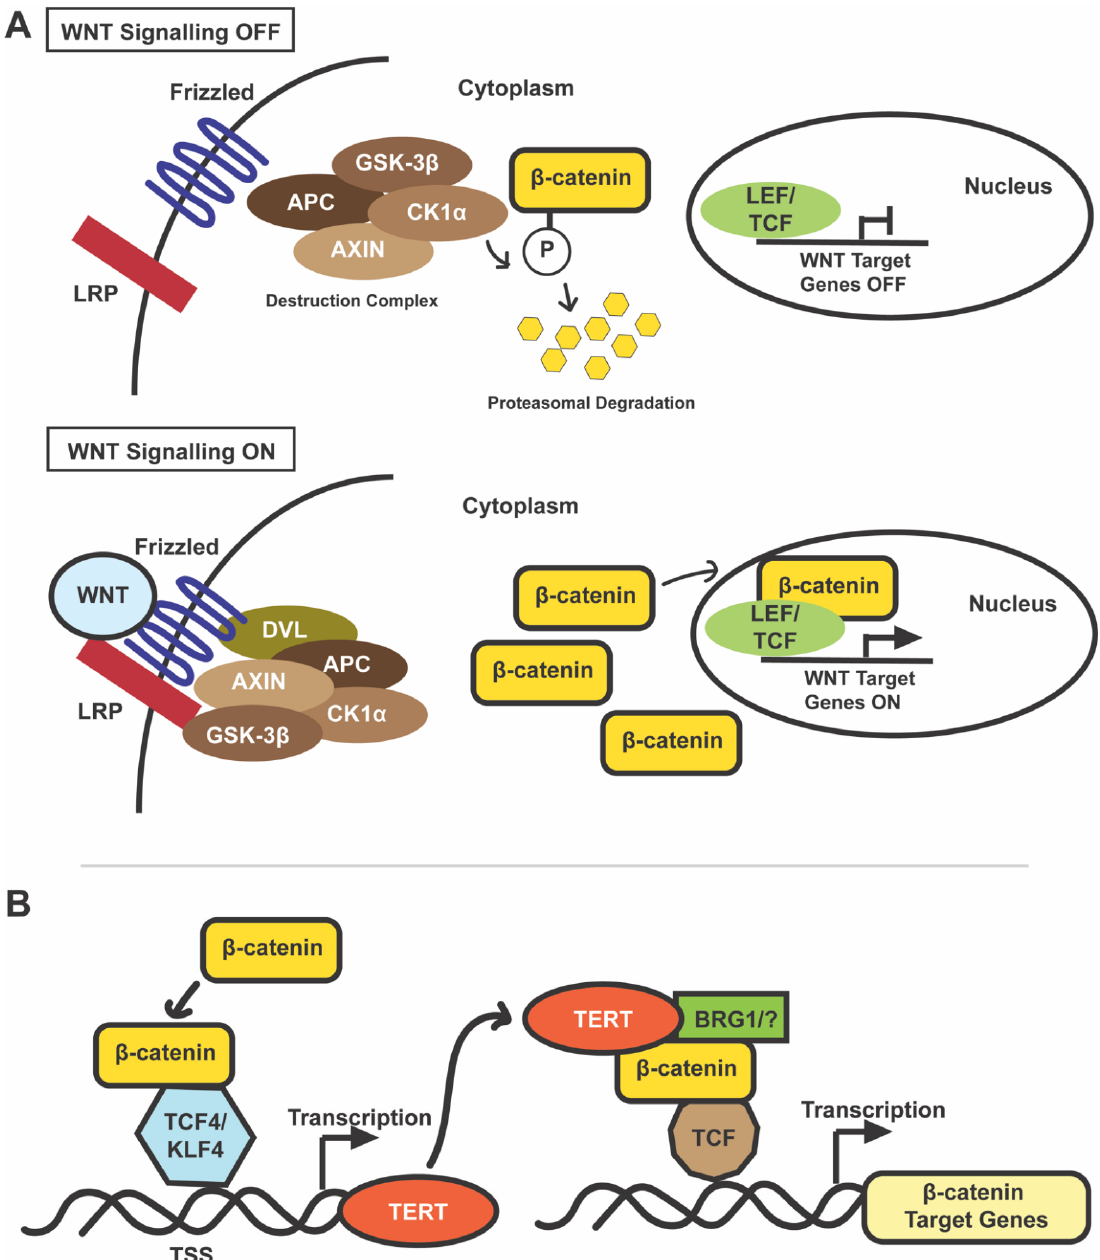
Figure 2. ( A ) Canonical WNT/ β -catenin pathway. When WNT signaling is OFF (top), cytoplasmic β -catenin is phospho- rylated by a destruction complex comprising of APC, AXIN, GSK-3 β , and CK1 α [58,59]. This phosphorylation marks it for proteasomal degradation, and consequently it is unavailable to bind to LEF/TCF elements in the nucleus to drive tran- scription of target genes [58,59]. When WNT signaling is ON, WNT ligands bind to LRP and Frizzled receptors leading to the destabilization of the destruction complex by a mechanism that may involve DVL protein [58,59]. The degradation complex is, thus, unable to phosphorylate and degrade cytoplasmic β -catenin [58,59]. β -catenin accumulates in the cyto- plasm and then enters the nucleus to bind to TCF/LEF elements and drive transcription of WNT target genes [58,59]. ( B ) Direct interplay of TERT and β -catenin signaling. β -catenin enhances transcription of TERT by binding to its promoter